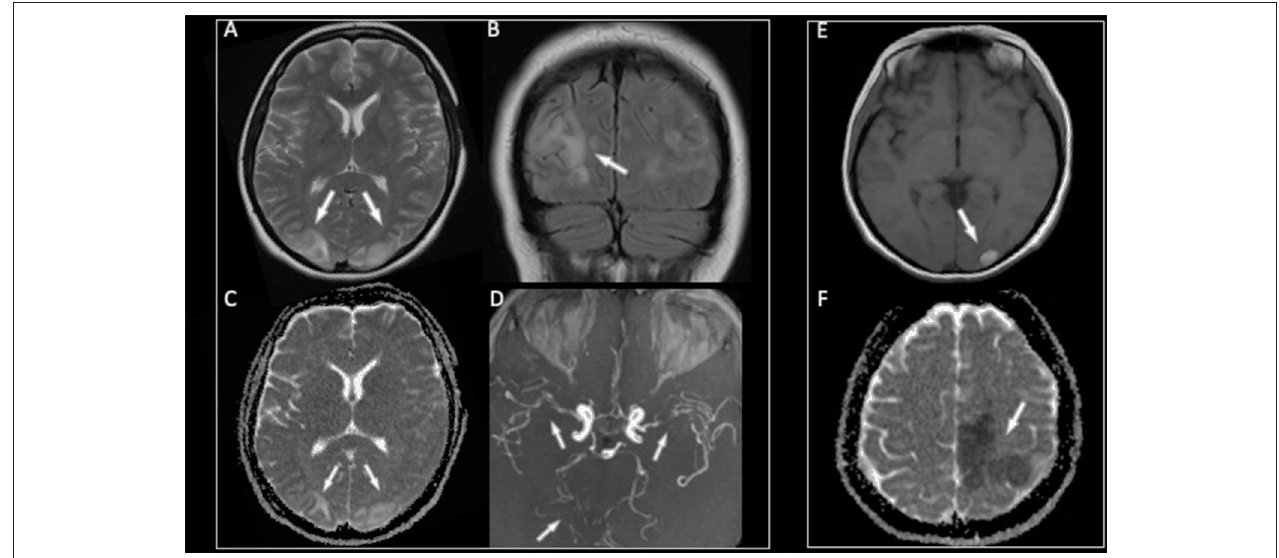
FIGURE 1 | The MR examination showing symmetric bilateral cortical and subcortical hyperintensities on T2-weighted and fluid-attenuated inversion recovery (FLAIR) images (A,B) in the parieto-occipital lobes with a high signal in the same areas on the ADC map (C) due to vasogenic edema. The 3D-TOF MR angiography (D) demonstrating multifocal segmental areas of narrowing and dilatation of both the anterior and posterior arterial circulations. After 1 week, a hemorrhagic complication characterized by a bright signal on T1-weighted images (E) has appeared in the left occipital lobe, while a new ischemic lesion with a low signal on the ADC map (F) was noted in the frontal